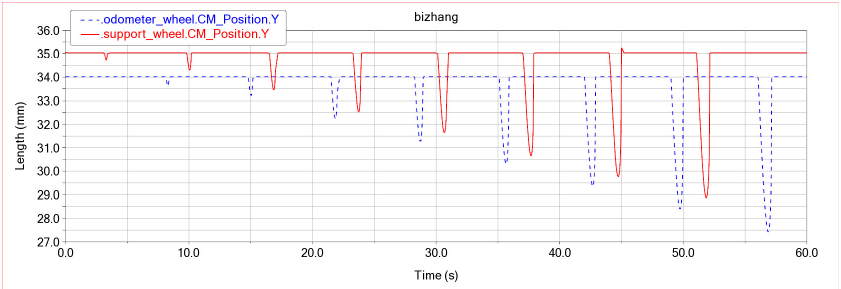
Figure 10. Variation in the height of the support and odometer wheels during the crossing of a ring weld in a straight